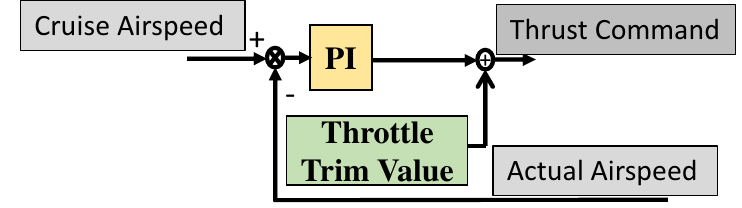
Figure 5. Velocity control